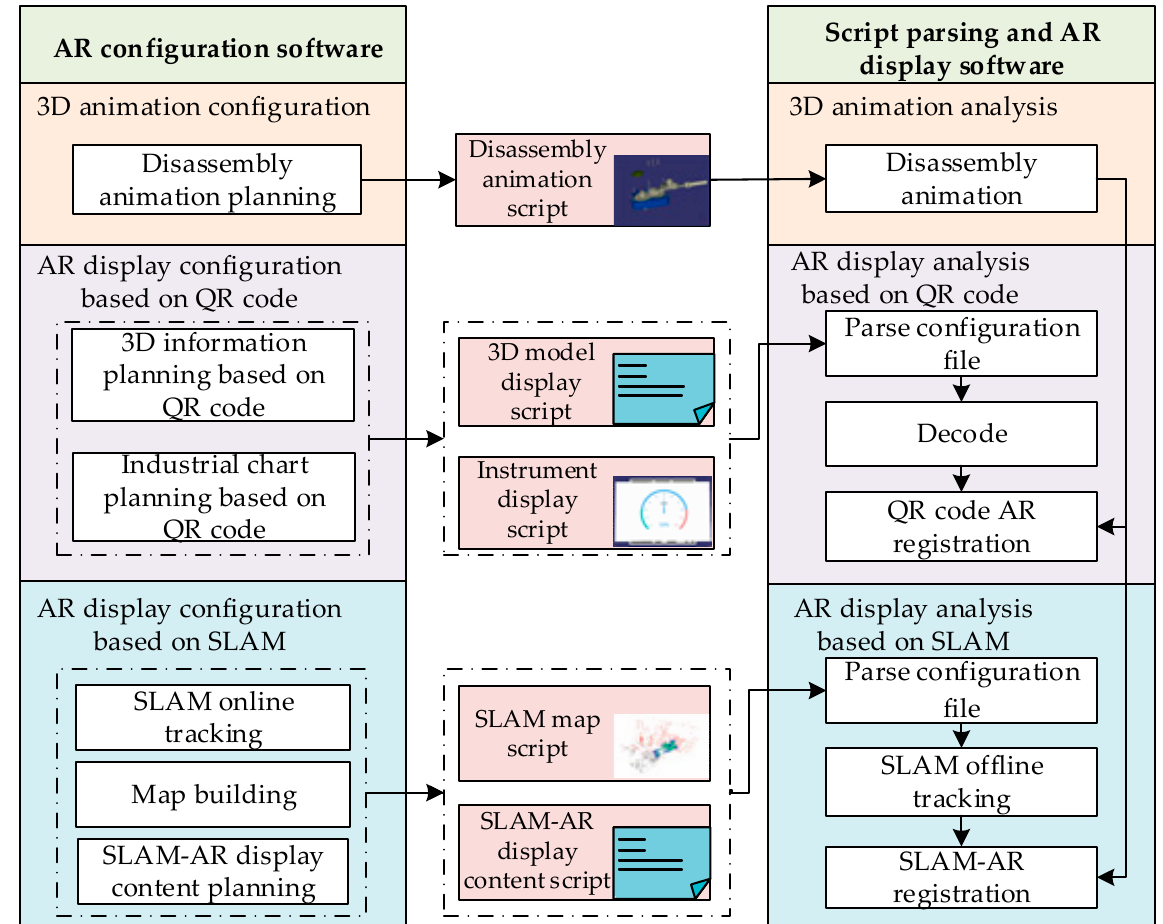
Figure 1. Overall frame diagram of the QDARV system.